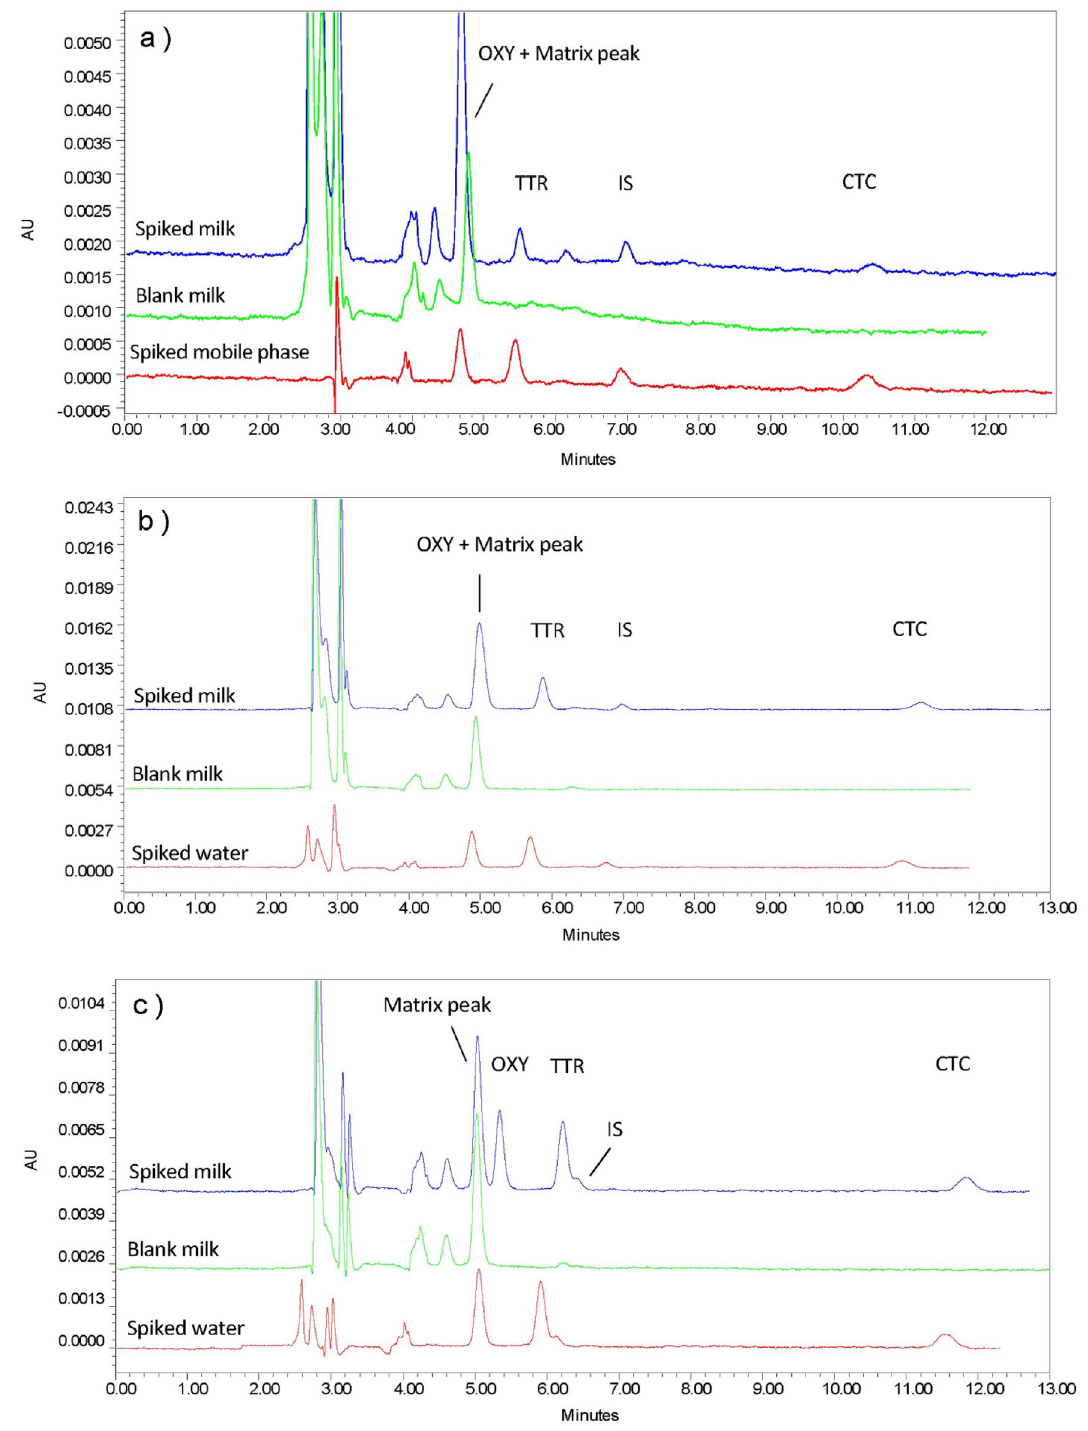
Figure 2. Effects of changing oxalic acid concentration on the drugs spiked cow milk. ( a ) 25 mM Oxalic acid:ACN: MeOH (70:20:10). ( b ) 30 mM Oxalic acid:ACN: MeOH (70:20:10). ( c ) 50 mM Oxalic acid:ACN: MeOH (70:20:10). Chromatographic conditions: Injection volume: 30 µL, Temperature: 25 ℃ ,Flow rate: 1 mL/ min, Detection wavelength: 358